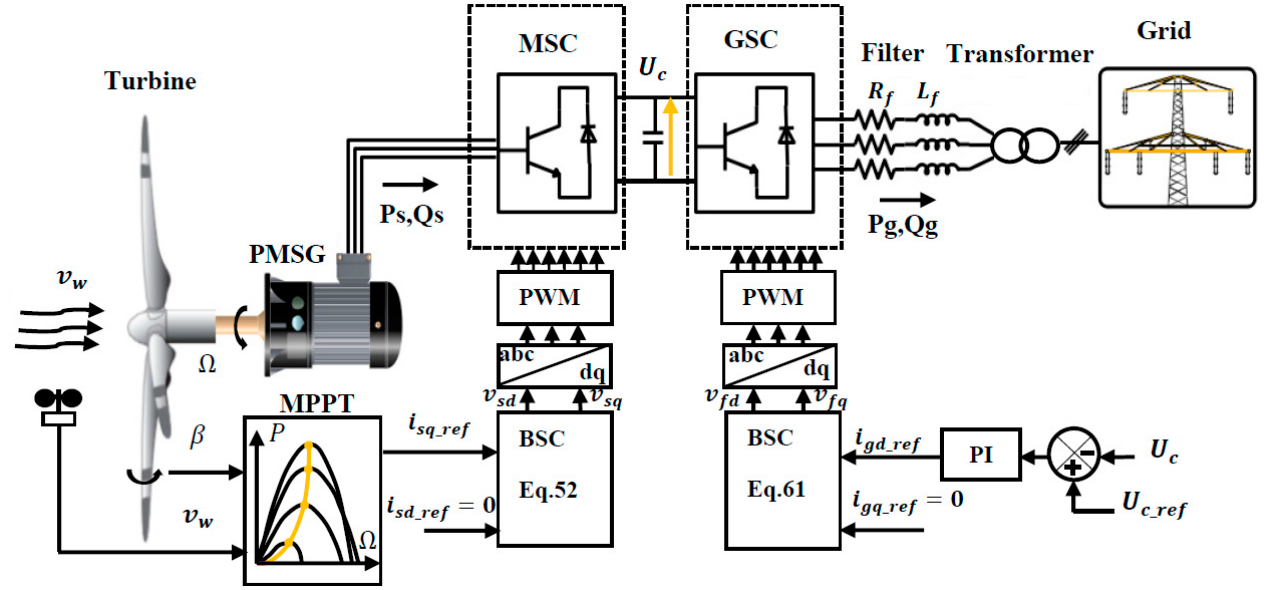
Figure 11. Synoptic schema of BSC applied to the PMSG-wind energy conversion system.